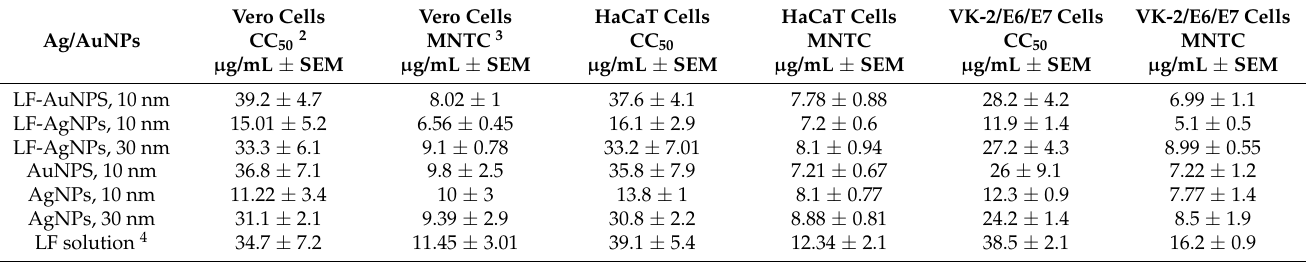
Table 1. Cytotoxicity of lactoferrin-modified 10 nm AuNPs, 10 nm AgNPs, and 30 nm AgNPs or corresponding lactoferrin solution in Vero, VK-2, and HaCaT cells 1